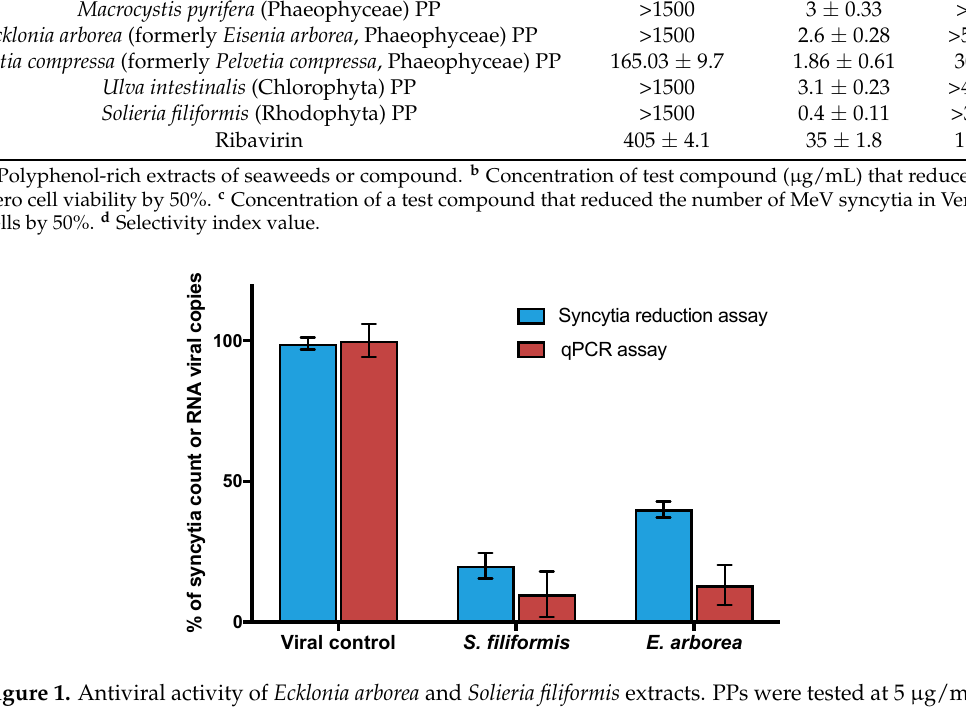
Table 2. Combined antiviral effect of PPs and SPs of Ecklonia arborea and Solieria filiformis.